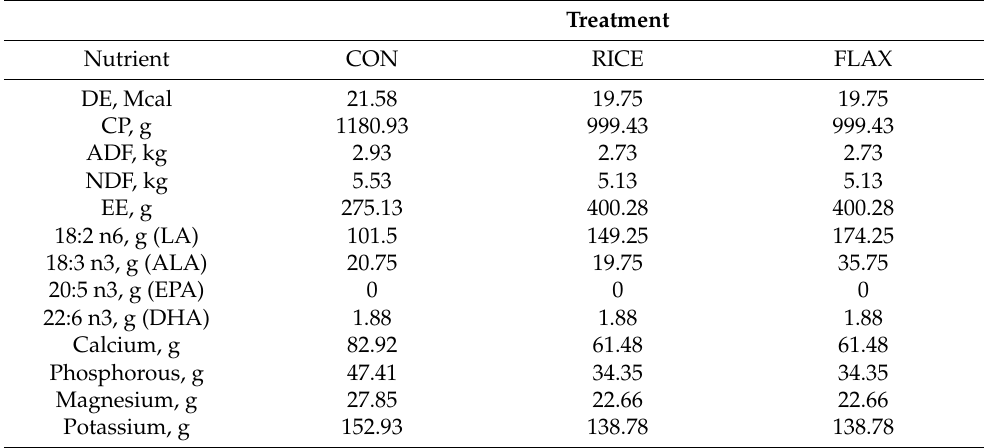
Table 2. Average daily nutrient intake of young horses consuming hay and a pelleted concentrate with no oil (CON) or either crude rice bran oil (RICE) or a flaxseed oil blend (FLAX) replacing 25% of concentrate calories daily for 60